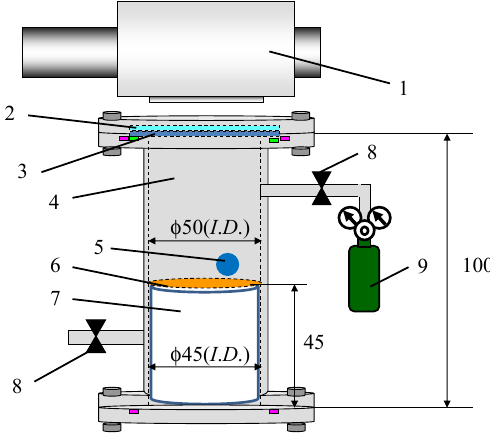
Figure 10. Schematic diagram of CO 2 reduction experimental apparatus. The reactor consists of stainless tube, Cu/TiO 2 film positioned on Teflon cylinder, a quartz glass disc, a sharp cut filter, a 150 W Xe lamp, mass flow controller, CO 2 gas cylinder.